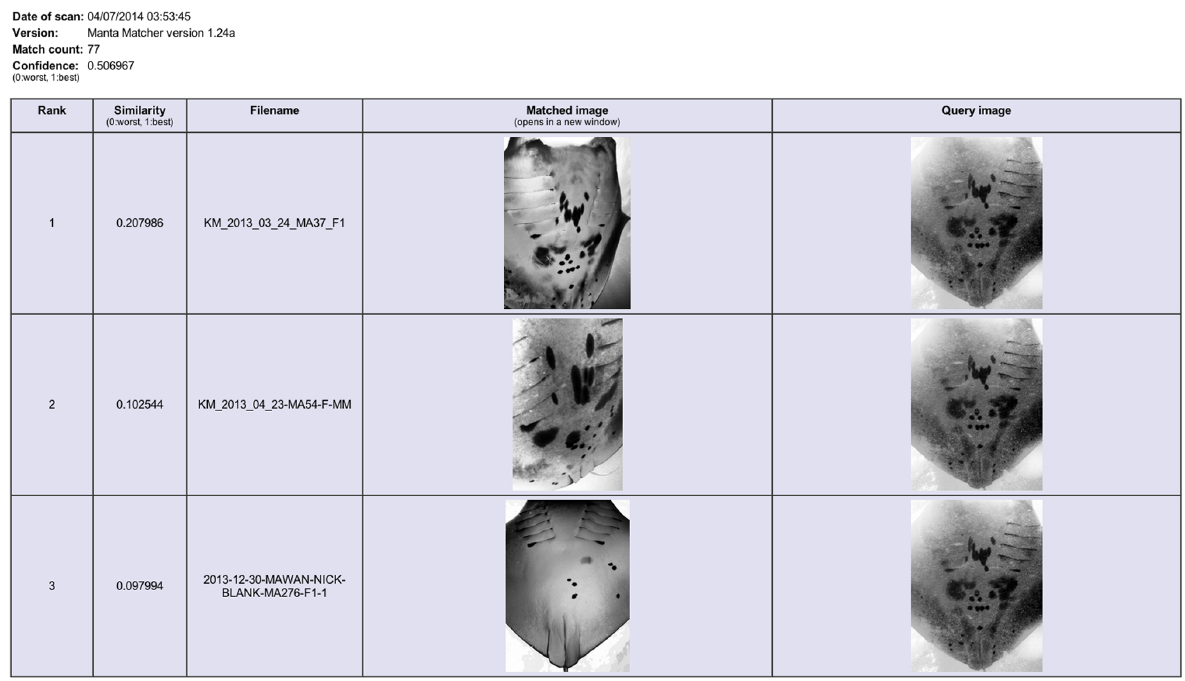
Figure 7. The ‘Manta Matcher’ matching algorithm screen grabs for INNLP0037A showing the top three matched images. Ranked hit 1 (re-sightings in WM & K) is a true match for the query image of ray INNLP0037A (initial sighting in NP).